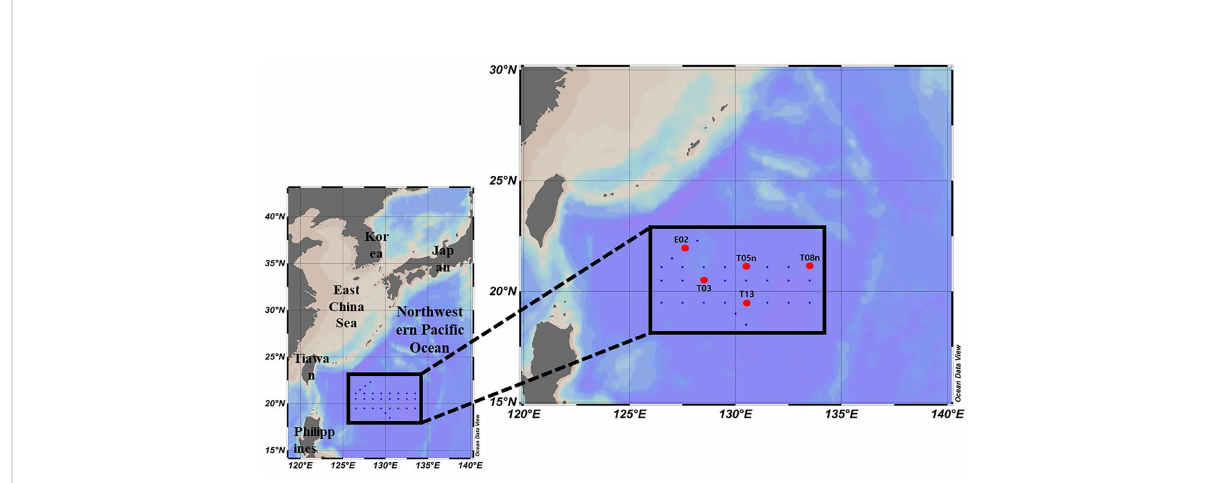
FIGURE 1 Sampling locations in the Philippine Sea, Northwestern Paci fi c Ocean (red circle: production